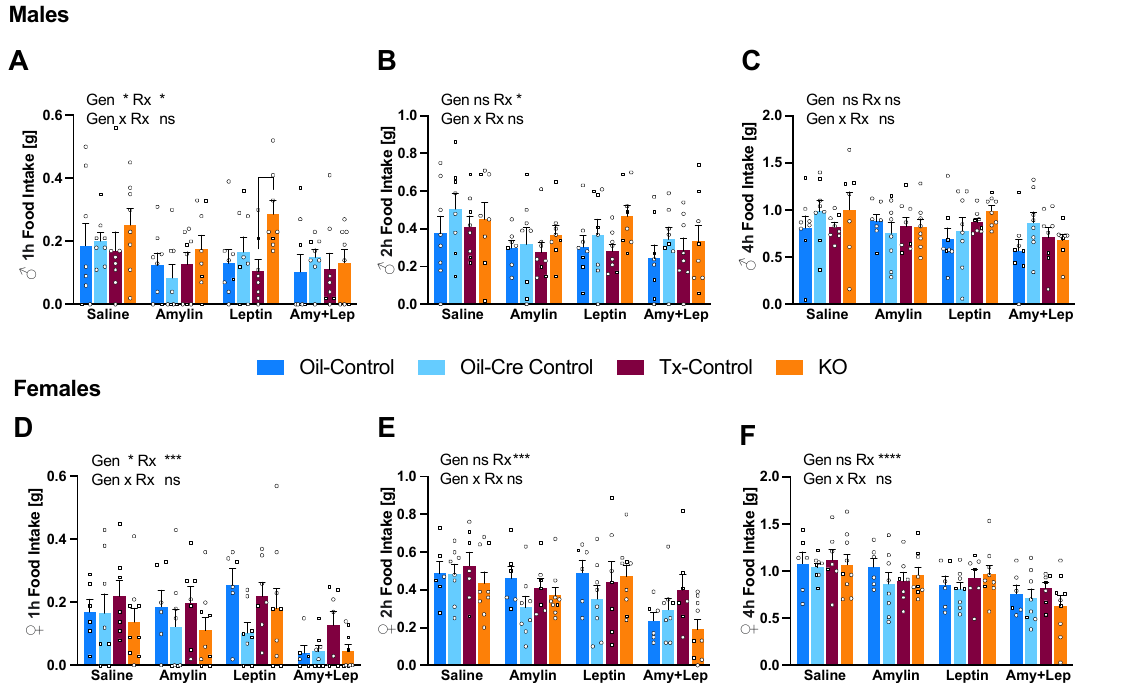
higher RER throughout the dark and light phase compared to male mice (Figure 5C,D). Figure 4. CTR depletion in microglia has no clear effect on food intake after amylin and leptin acute injection . Chow diet-fed mice (cohort 1) were fasted for 12 h during light phase and injected with a single dose of amylin (i.p.; 50 µ g/kg), leptin (i.p.; 5 mg/kg), or a combination of both in a crossover study design with three days of washout between injections. Food intake 1 h, 2 h and 4 h post- injection is displayed for male ( A – C ) and female ( D – F ) mice. Data are displayed as mean ± SEM; n = 8–10 male mice and 6–9 female mice per group. Summary statistics after two-way ANOVA (genotype = Gen; treatment = Rx; * p < 0.05, *** p < 0.001, **** p < 0.0001) detected treatment effects ( A , B , D – F ) and genotype effects ( A , D ) but only one significant intergroup difference was found after Tukey’s post-hoc test (1 h food intake after leptin treatment, Tx-control vs. KO, ( A )).